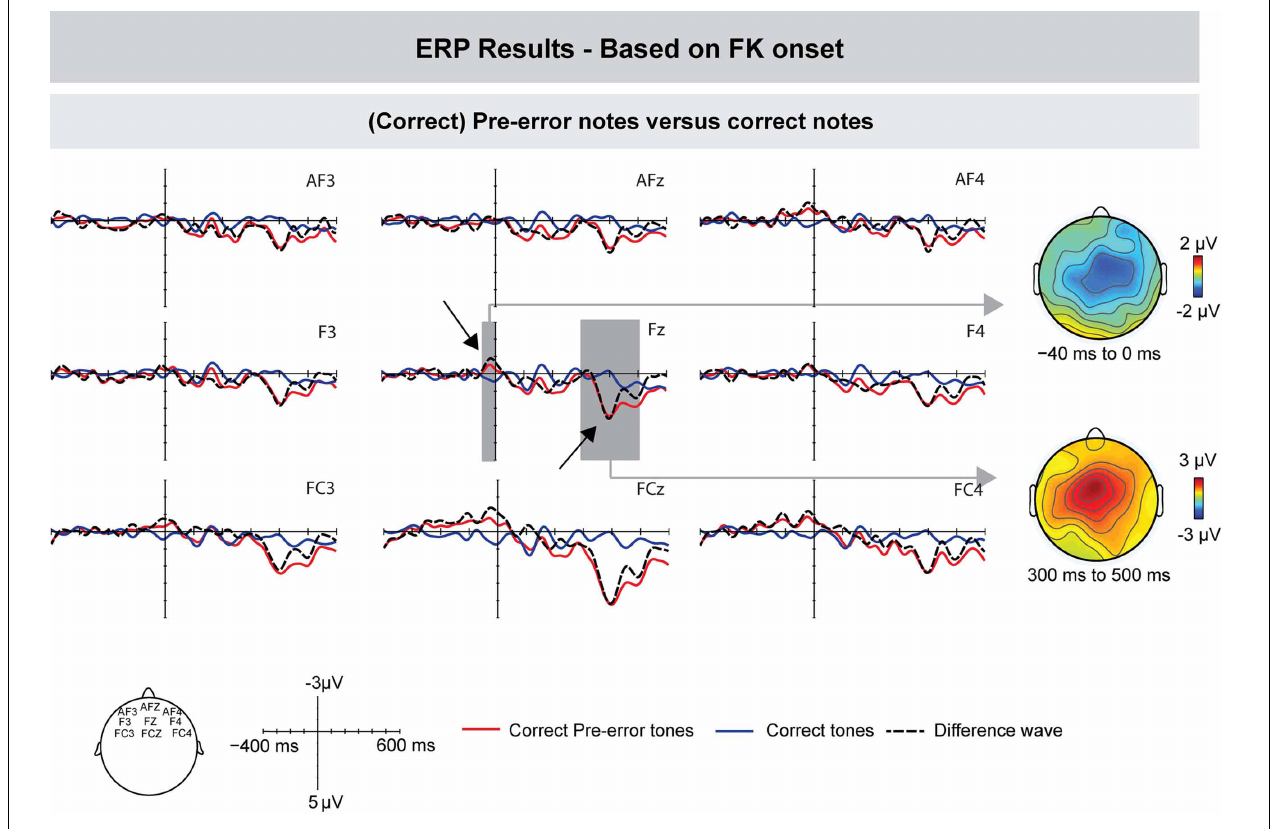
FIGURE 6 | Grand-averaged ERPs (left) and scalp topographies (right) based on the movement data. Compared to other correct keystrokes, pre-error notes showed an increased negativity shortly before FK onset, followed by a positive deflection around 350ms.